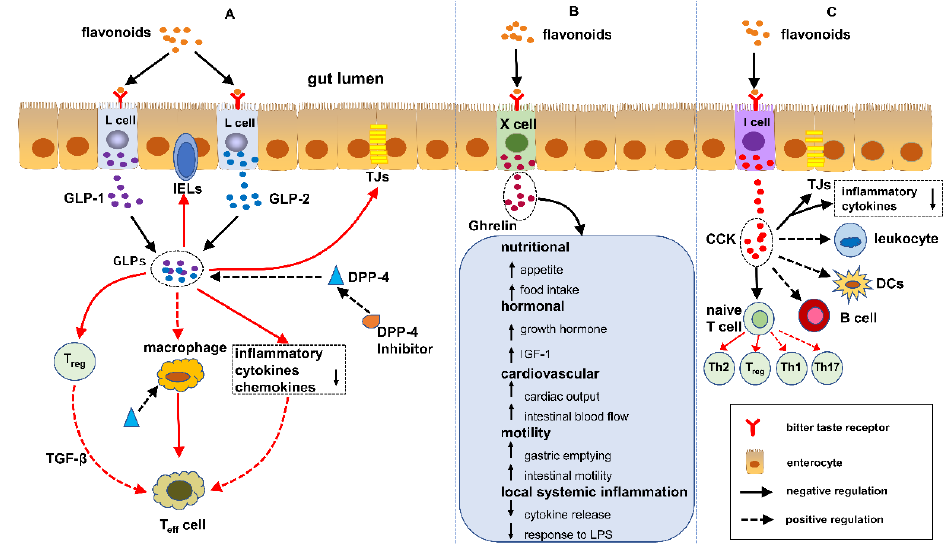
Figure 3. ( A ) Flavonoids regulate IBD by the DPP-4/GLPs pathway: (1) protecting the intestinal barrier, (2) modulating Treg and intraepithelial lymphocytes (IELs) by managing their differentiation and functions and (3) adjusting the function of macrophages and dendritic cells. ( B ) Flavonoids regulate IBD by the ghrelin pathway: (1) increased food intake, (2) increase in growth hormone ac- tivity, (3) cardiovascular effects, (4) increased motility and (5) decreased local and systemic inflam- mation. ( C ) Flavonoids regulate IBD by the cholecystokinin (CCK) pathway: (1) decreasing the mu- cosal production of proinflammatory cytokines and protecting the intestinal barrier, (2) attenuating leukocyte migration and inhibiting dendritic cells (DCs) activation and (3) regulating T cells and B cells. Table 2. Modulation of IBD by GLPs and DPP-4 inhibitors.